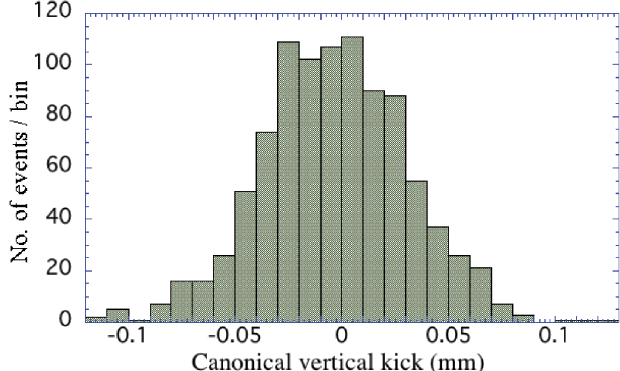
FIG. 3. (Color) Histogram of the canonical vertical kick. The data is the same as that in Fig. 2. The target value is subtracted so that the center of the distribution is at